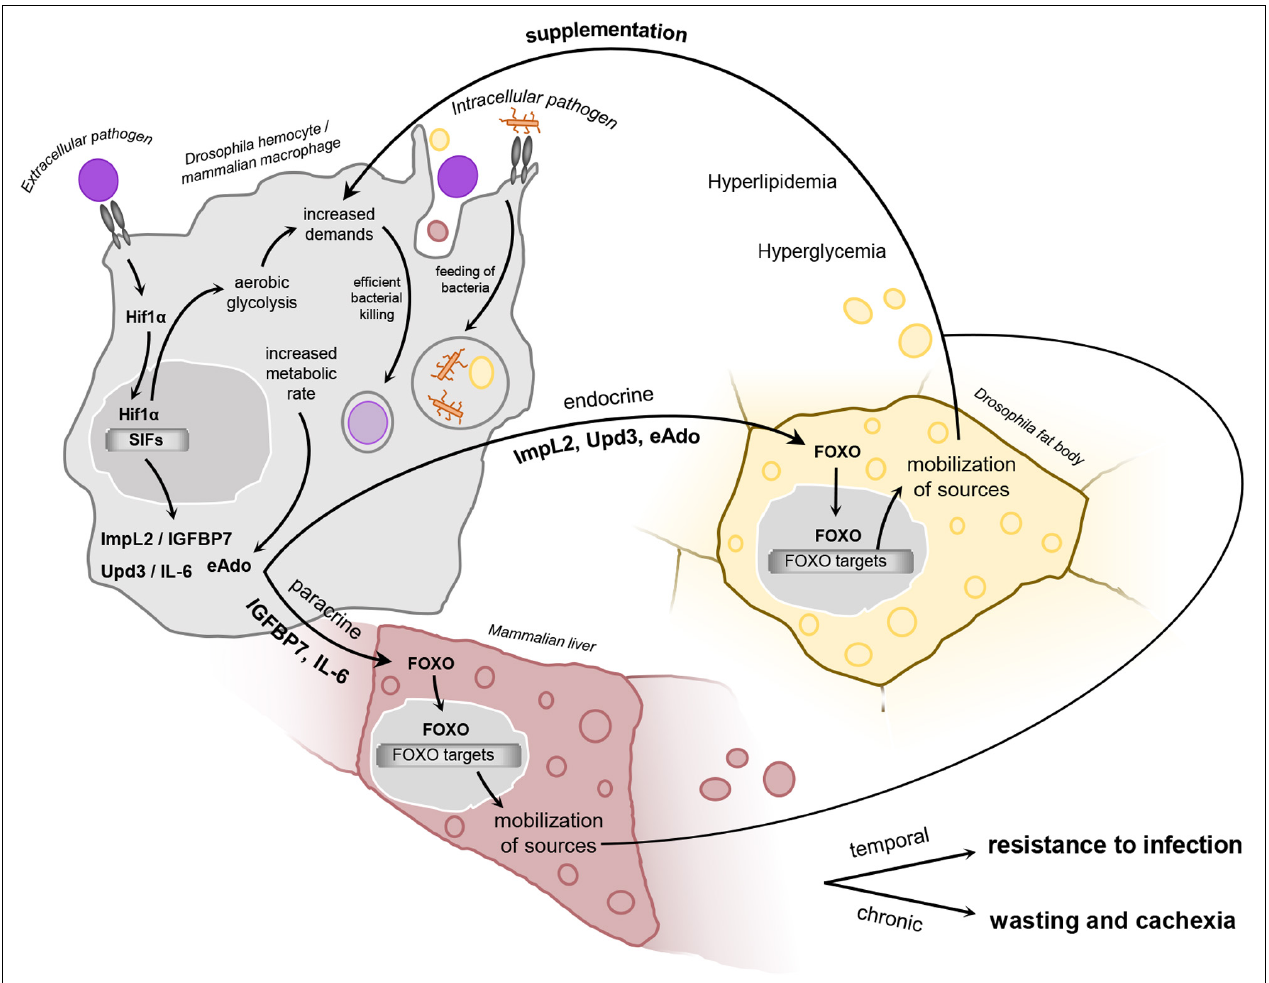
FIGURE 3 | Schematic representation of the proposed hypothetical model. In infection-activated macrophages, HIF1 α stabilization leads to adoption of aerobic glycolysis, which is a highly energy demanding metabolic program. Aerobic glycolysis is interconnected with the production of selfish immune factors. These molecules affect remotely the metabolism of the main storage organs via induction of insulin resistance, leading to FOXO nuclear translocation and induction of mobilization of sources. This results in elevated titer of circulating carbohydrates and lipids, which are thus utilized by bactericidal macrophages to supplement their increased energy demands. Such inter-organ communication is essential for resistance to infection by extracellular pathogen, but may be maladaptive upon its chronic activation or in case of infection by intracellular bacteria. Hif1 α , hypoxia-inducible factor 1 α ; FOXO, forkhead box O; Upd3, unpaired 3; ImpL2,